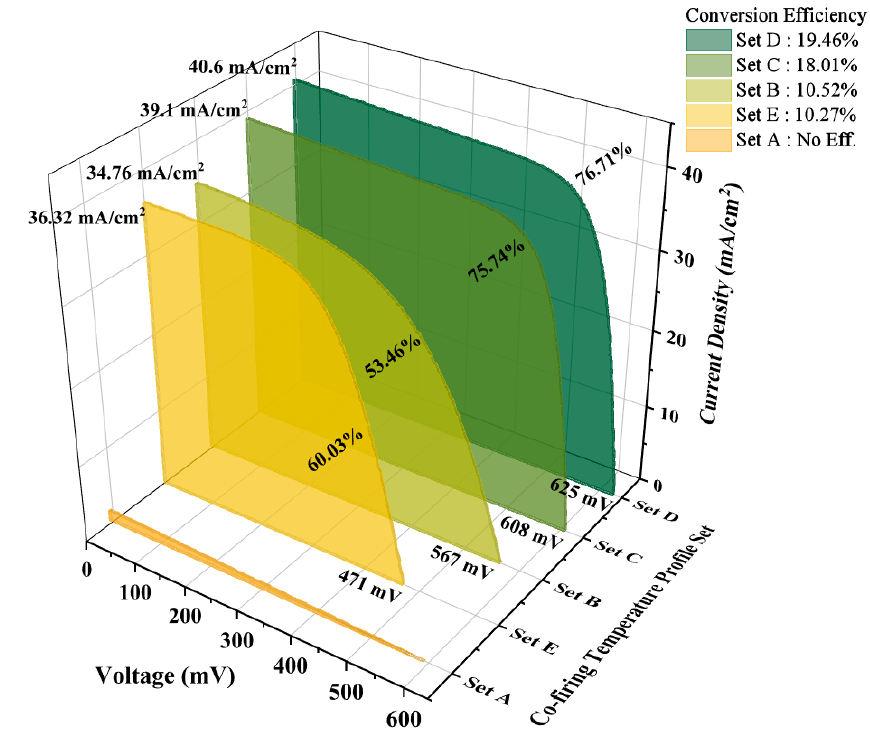
Figure 7. Output illumination current-voltage (LIV) characteristics of the fabricated n-type substrate solar cell for different co-firing temperature profile sets.